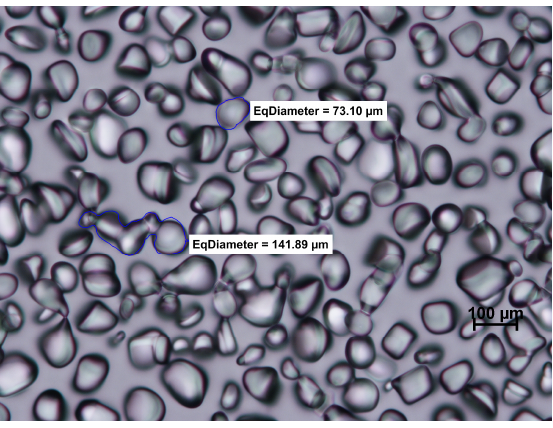
Figure 1. Microscopic image of ice crystals in model sucrose solution (50%) after 96 h of storage at −8 °C; coalescence visible (own work, not published).